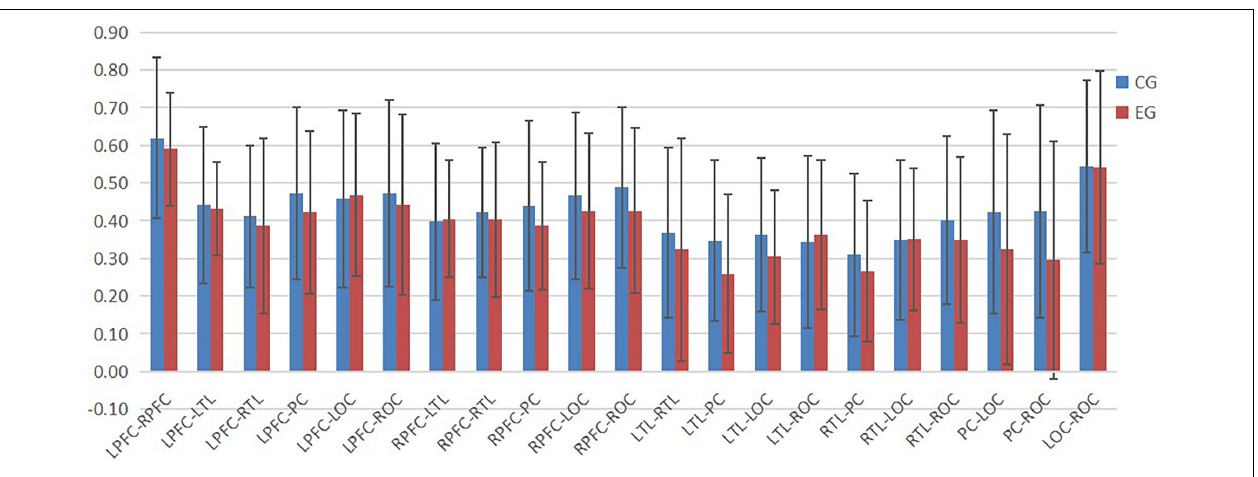
FIGURE 6 | The ROI connection strength for control and cognitive impairment groups of Task 3.